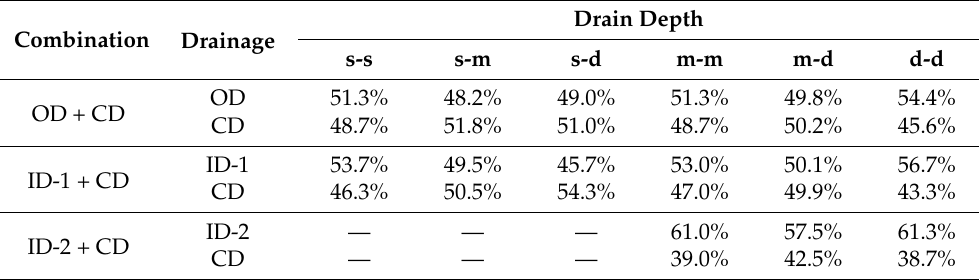
Table 2. Contribution degree of different drainage measures under different combined drainage